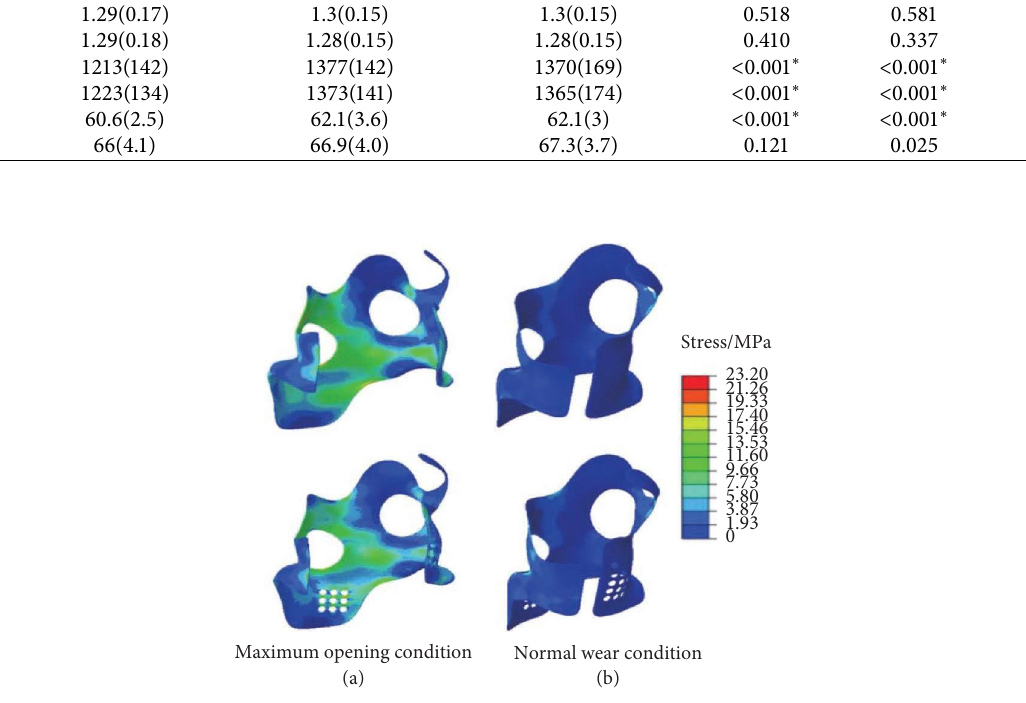
Figure 8: Stress distributions of scoliosis orthosis. (a) Maximum opening and closing state. (b) Normal wearing